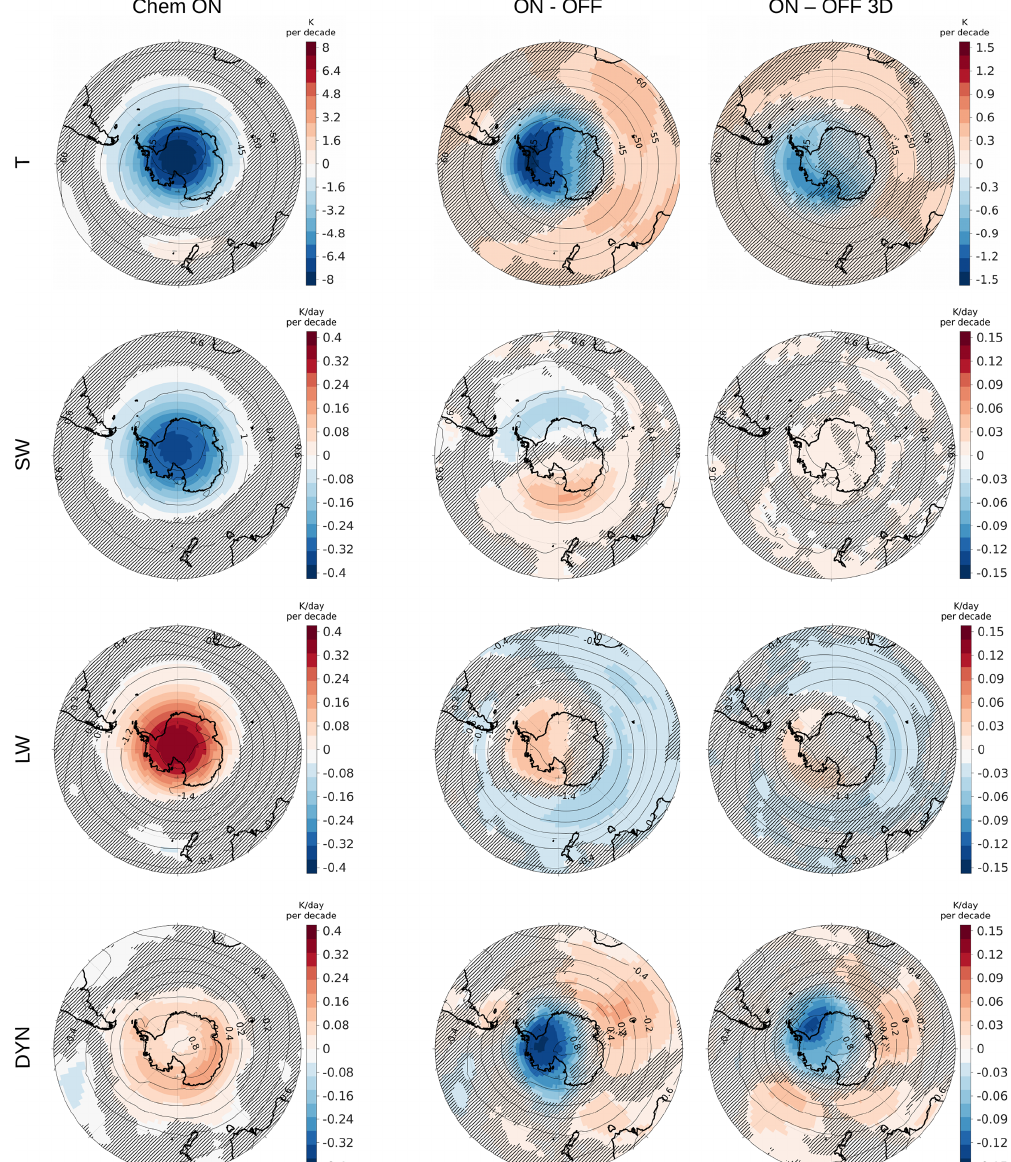
Figure 12. Temperature ( T ), shortwave heating rate (SW), long-wave heating rate (LW) and dynamical heating rate (DYN) trends in kelvin per decade and kelvin per day per decade at 50hPa for 1969–1998 in December (shading) for (left panels) Chem ON, (middle panels) Chem ON minus Chem OFF and (right panels) Chem ON minus Chem OFF 3D. The particular climatologies (contours) are represented for Chem ON during the same period with an interval of 5K for T and 0.2Kd − 1 for SW and DYN. Statistically insignificant regions are hatched at the 5% level based on a Mann–Kendall